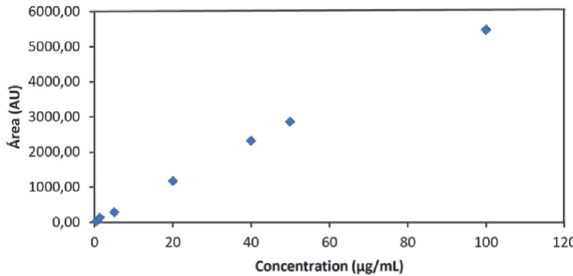
Figure 2 . Calibration curve obtained with insulin standard solu- tions at seven concentration levels in the range of 0.5 to 100 µg/mL (n = 21).